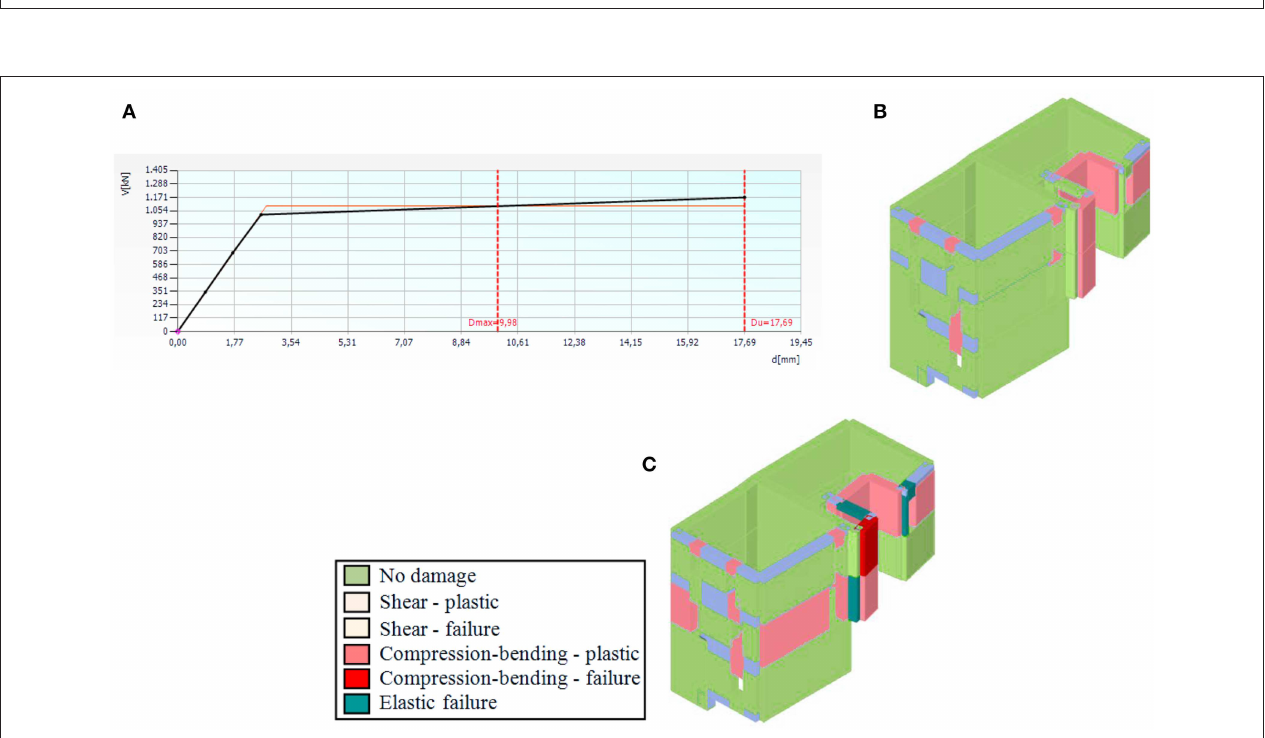
FIGURE 9 | Seismic behavior in direction Y of the isolated S.U. type B: MDOF pushover curve (A) and damage patterns related to the conventional yielding limit (B) and ultimate displacement D u (C) .